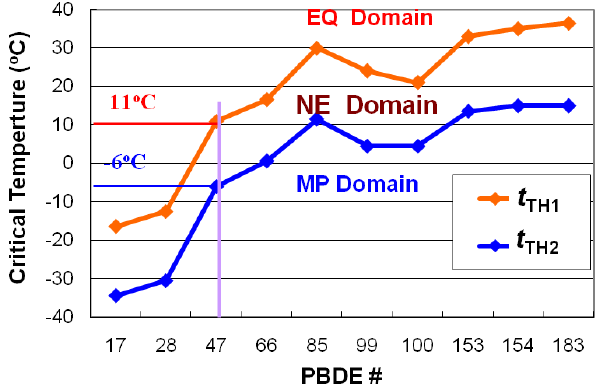
Figure 2. The first and second threshold temperatures, t TH1 and t TH2 for 10 PBDE congeners, which divide the temperature space into the same three domains (EQ, NE, and